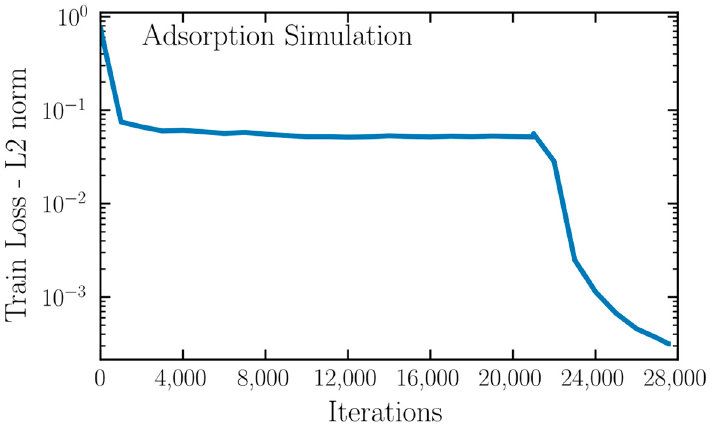
Figure 3. Train loss history for numerical adsorption experiment.